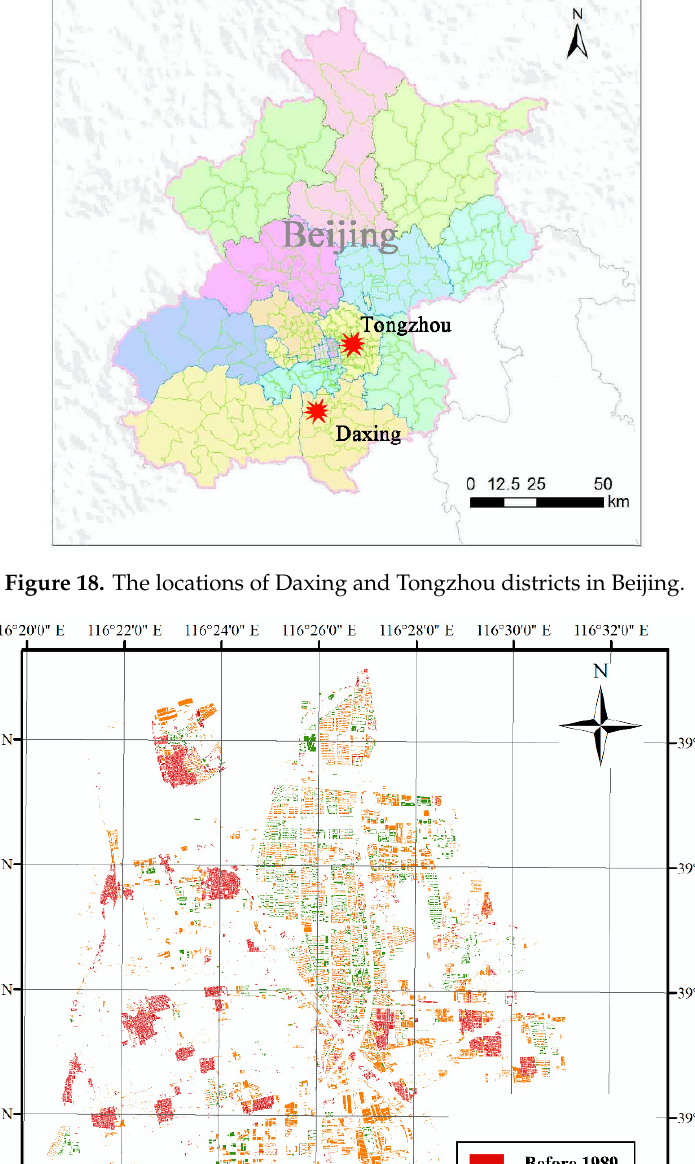
Figure 18. The locations of Daxing and Tongzhou districts in Beijing.